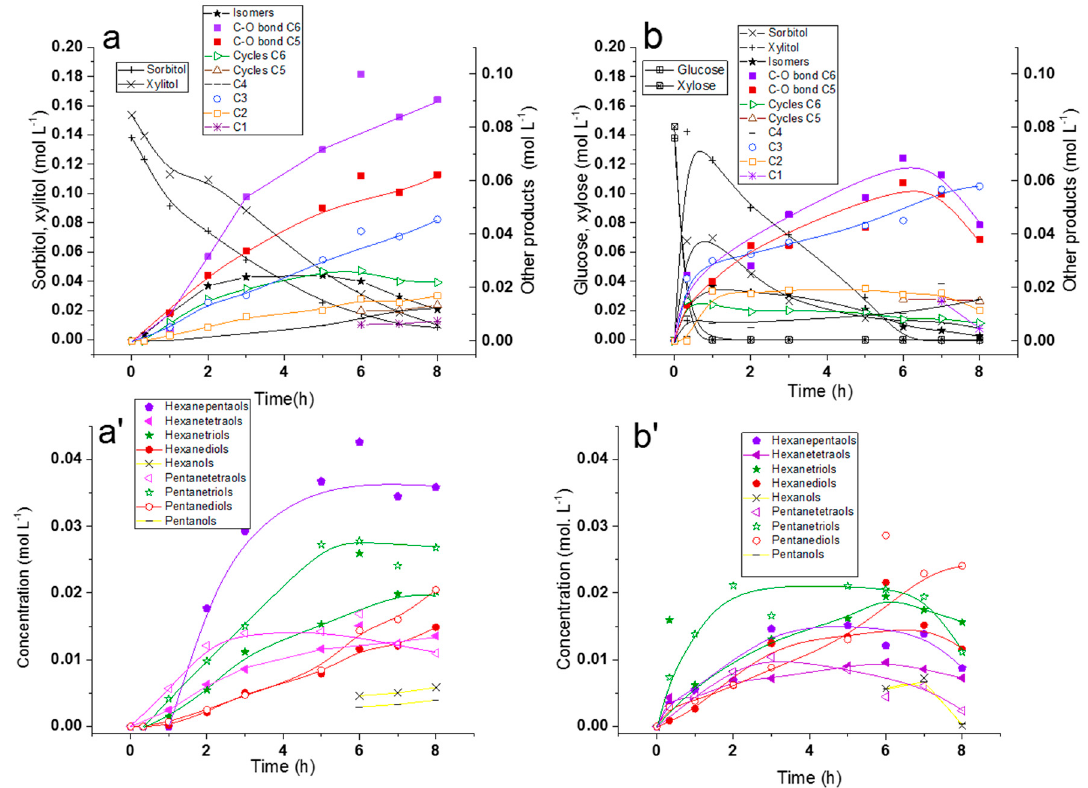
Figure 4. Evolution of concentrations of: ( a , b ) families of products and ( a’ , b’ ) C-O bond cleavage C6 and C5 sub-families during hydrogenolysis of ( a , a’ ) mixture of sorbitol (0.14 M) and xylitol (0.15 M) and ( b , b’ ) of mixture of glucose (0.14 M) and xylose (0.15 M) over ReO x -Rh / ZrO 2 (Re / Rh = 1.6) at 200 ◦ C under 80 bar H 2 , n substrate / n Rh = 218.